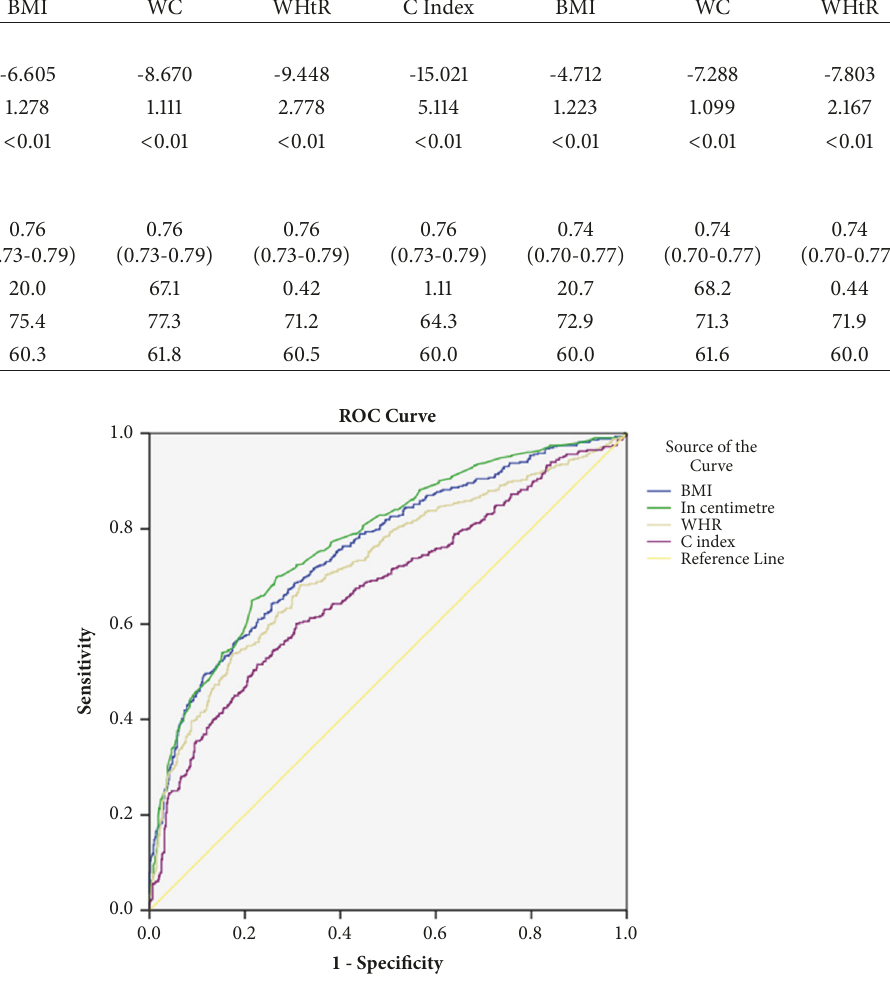
Figure 1: ROC curves that compare four anthropometric indicators of obesity as discriminators of hypertension (boys). BMI: body mass index, in centimeter-waist circumference; WHR: waist-height ratio; C index: conicity